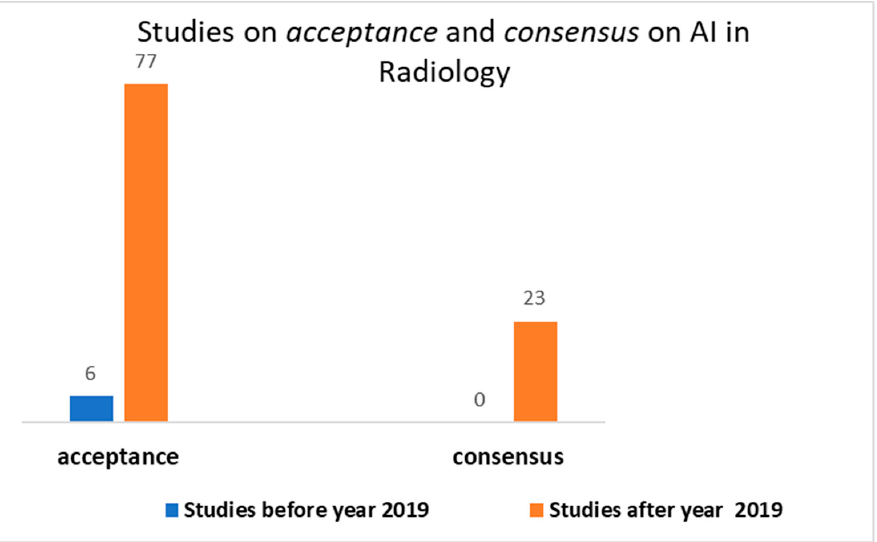
Figure 1. Output of the search on PubMed on acceptance and consensus on AI in radiology.